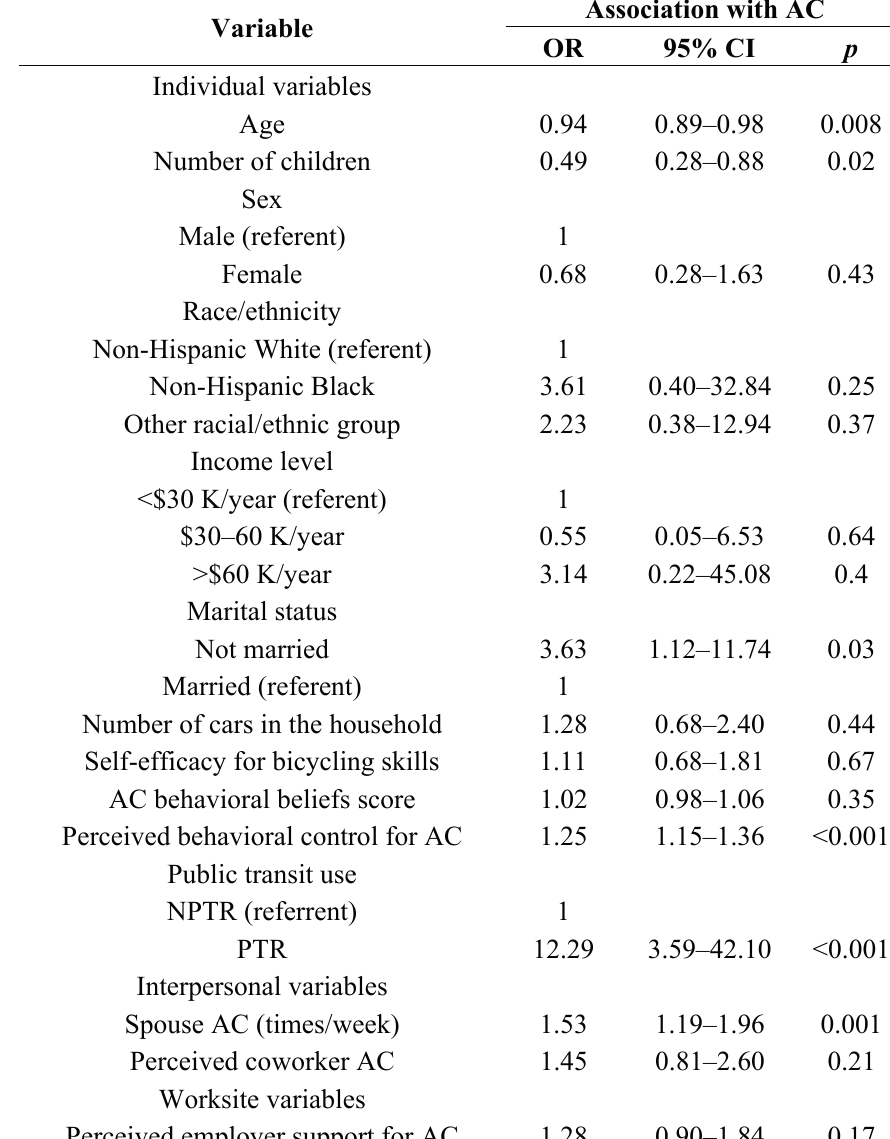
Table 3. Logistic regression for Active Commuting (yes/no) ( n =